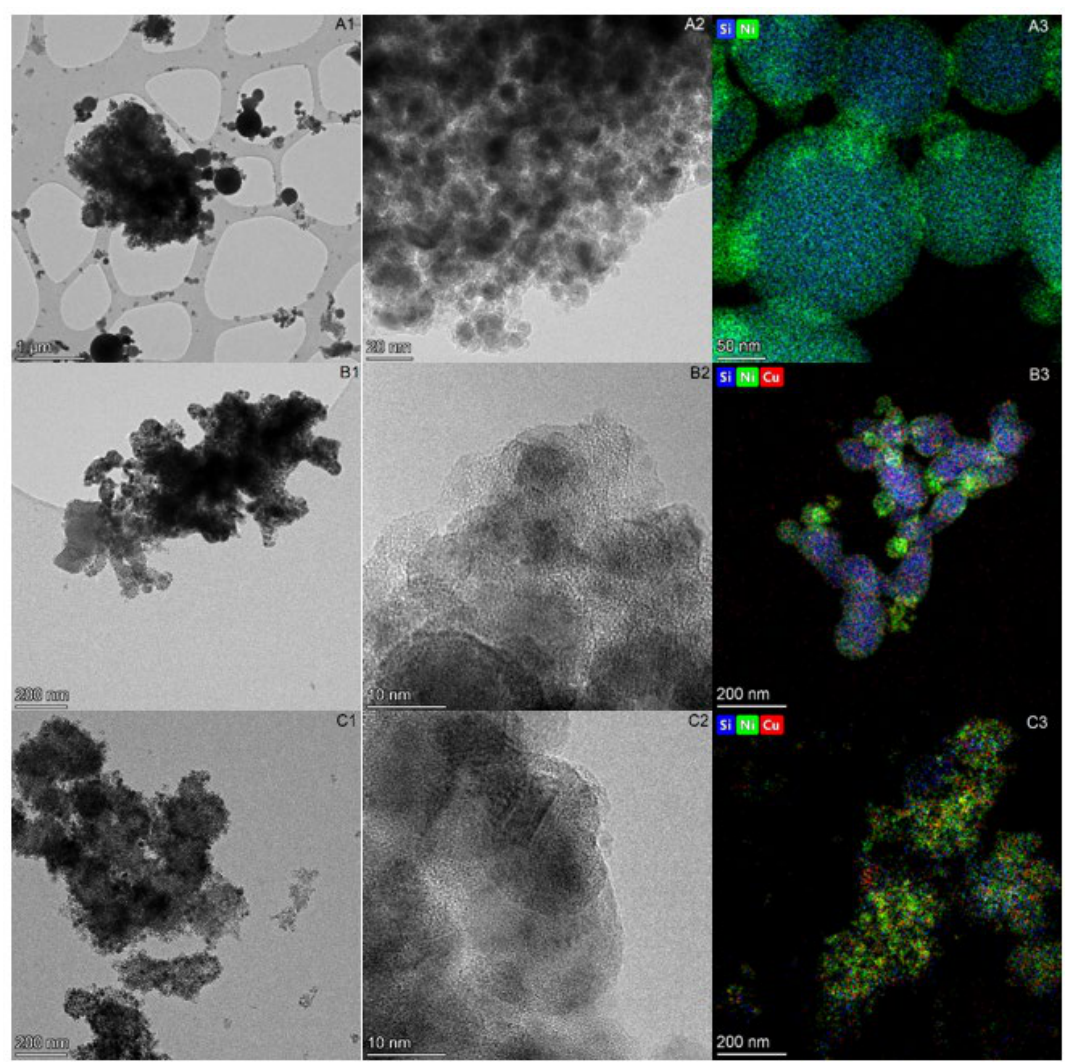
Figure 3. TEM and EDX mapping images obtained for ( A ) Ni(36)–SiO 2 , ( B ) Ni(41)Cu(4)–SiO 2 , ( C ) Ni(36)Cu(14)–SiO 2 .